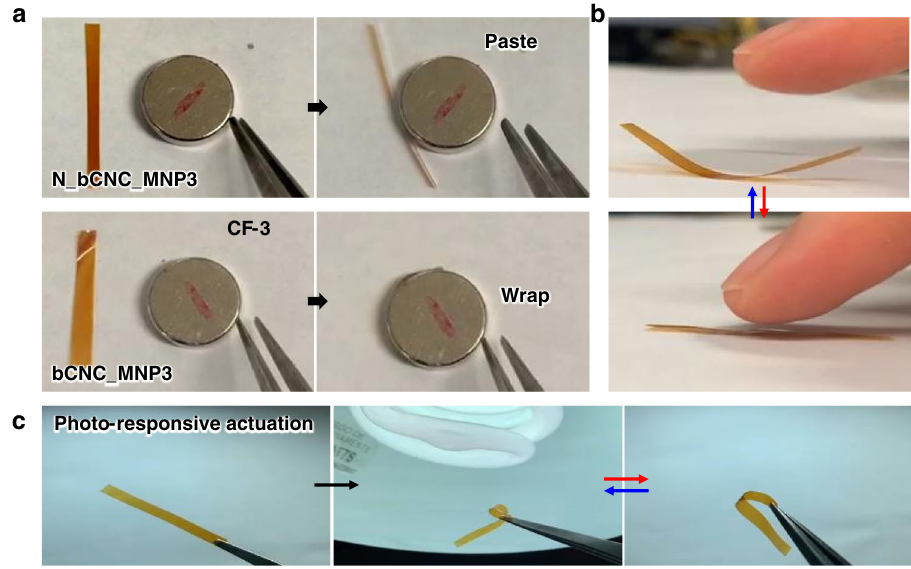
Fig. 7 | Multi-stimuli responsive behavior of magnetic fi lms. a Magnetic responsivebendingofbCNC_MNP3 fi lmsinthepresenceofthepermanentmagnet.